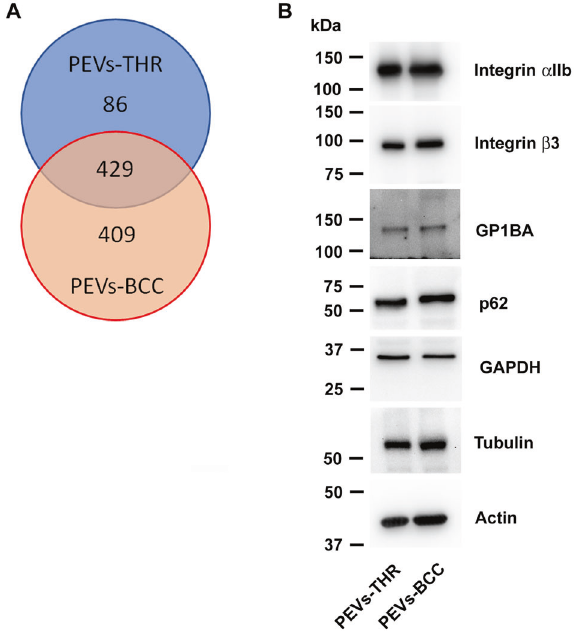
Fig. 3 Proteomic pro fi ling of PEVs. A Venn diagram reporting the number of proteins identi fi ed in the PEVs-THR and PEVs-BCC samples by LC-MS. B Representative immunoblots of selected proteins expressed in PEVs: integrin α IIb, integrin β 3, GPIb α (GP1BA), p62, GAPDH, tubulin and actin, as